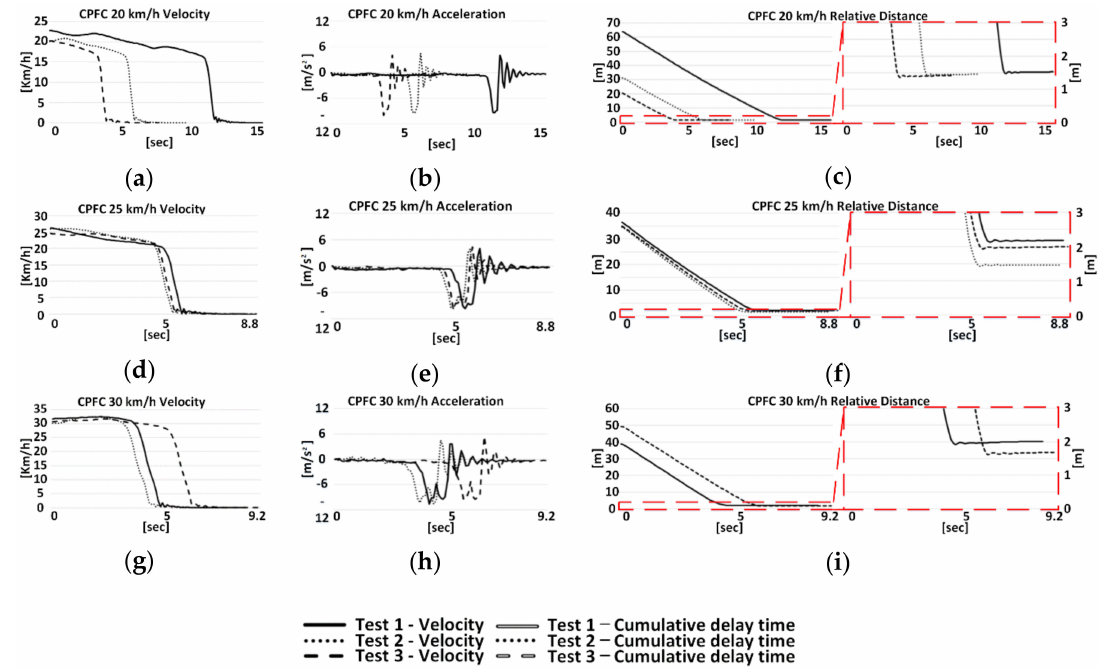
Figure 12. Test results (CPFC) ( a ) 20 km / h test velocity & cumulative delay time ( b ) 20 km / h test acceleration ( c ) 20 km / h test relative distance ( d ) 25 km / h velocity & cumulative delay time ( e ) 25 km / h test acceleration ( f ) 25 km / h test relative distance ( g ) 30 km / h velocity & cumulative delay time ( h ) 30 km / h test acceleration ( i ) 30 km / h test relative distance.